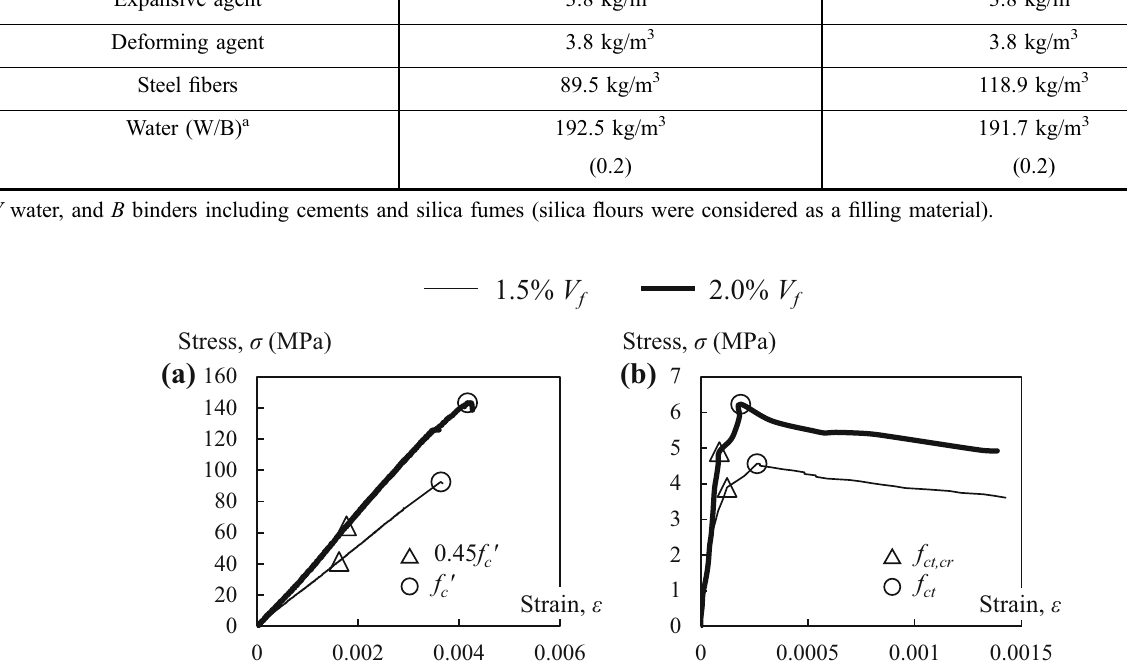
Fig. 3 Stress–strain curves of UHPFRC: a compression test result and b tension test result.